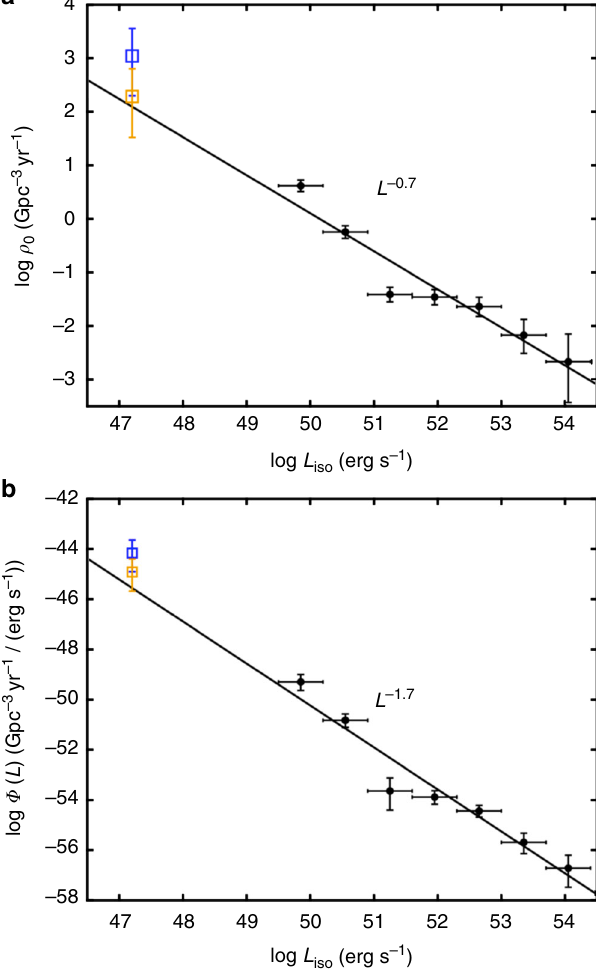
Fig. 4 Distributions of local event rate density and luminosity function. a The local event rate density distribution of sGRBs including GRB 170817A. The orange symbol with error denotes the event rate density derived from GRB 170817A and the blue symbol with error denotes the DNS merger event rate density derived from GW170817. The black power-law line and other data points were derived from the Swift sGRB sample 6 . The vertical error bar represents the 1 σ Gaussian errors derived from ref. 35 . b Luminosity function distribution of sGRBs including GRB 170817A, with labels same as the upper panel. All error bars represent 1 − σ